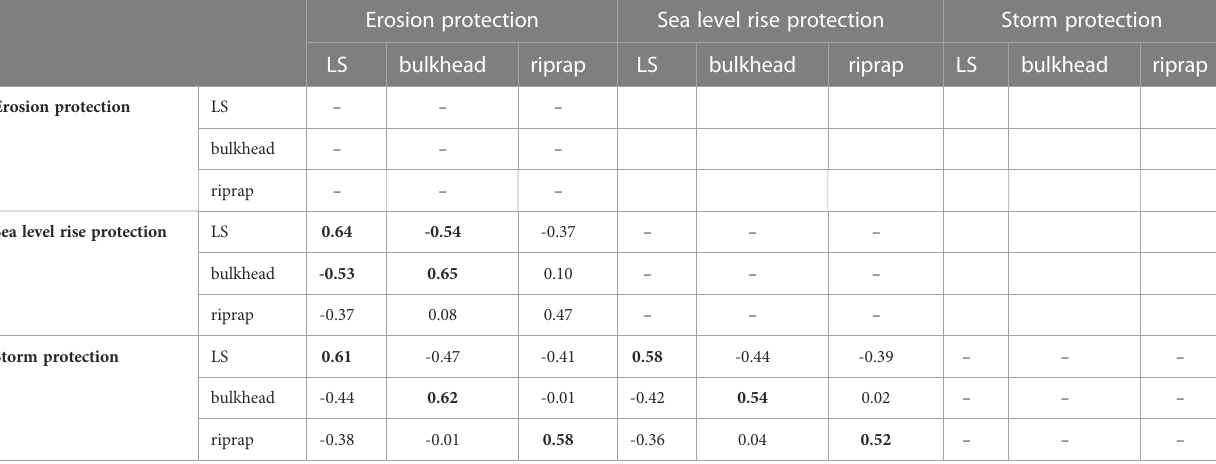
TABLE 3 Perceived protection bene fi ts